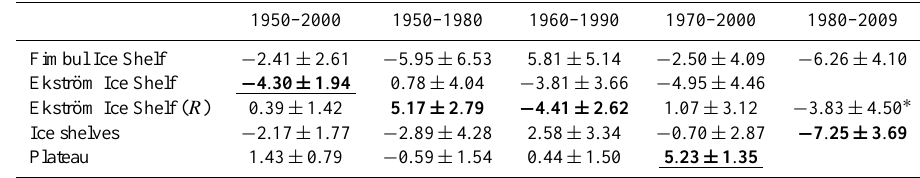
Table A3. Linear trends [kgm − 2 decade − 1 ] for the stacked records of SMB. Significant trends according to F test on the 95% (bold and underlined) and 90% confidence level (bold) are highlighted. The standard deviation of the slope is also